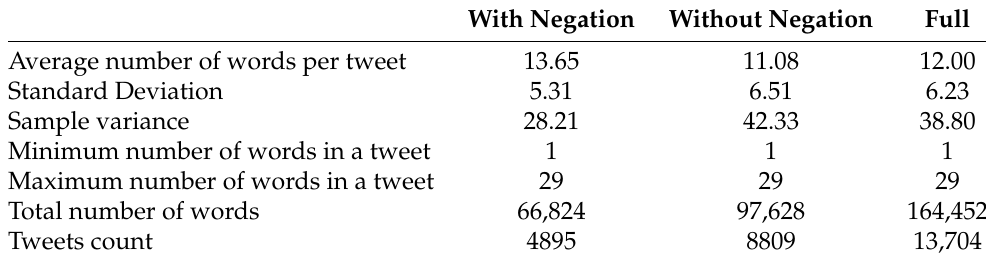
Table 3. General statistics computed from word counts on each tweet.